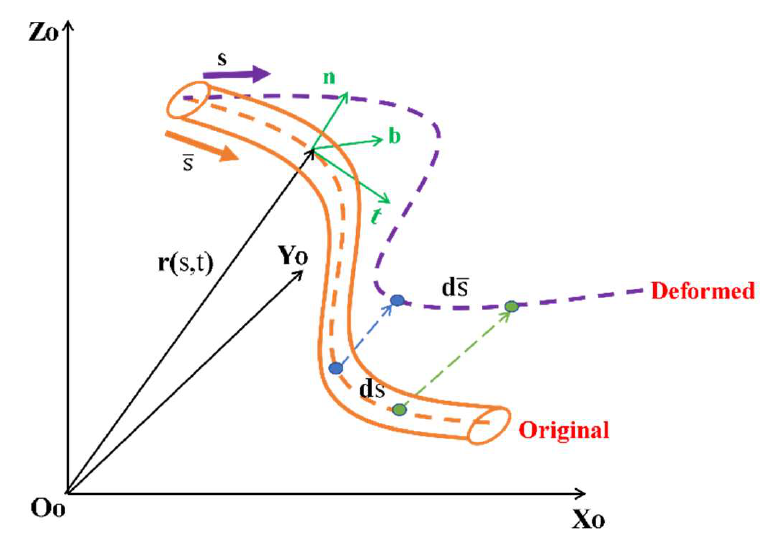
Figure 2. The rod in original and deformed state.